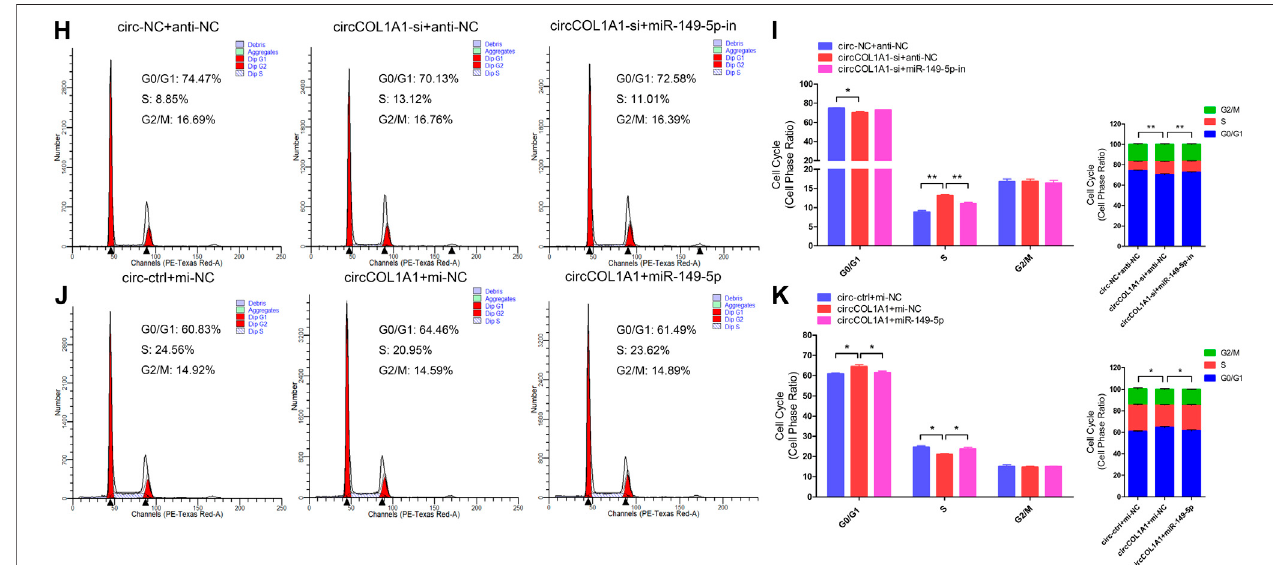
Frontiers in Cell and Developmental Biology |